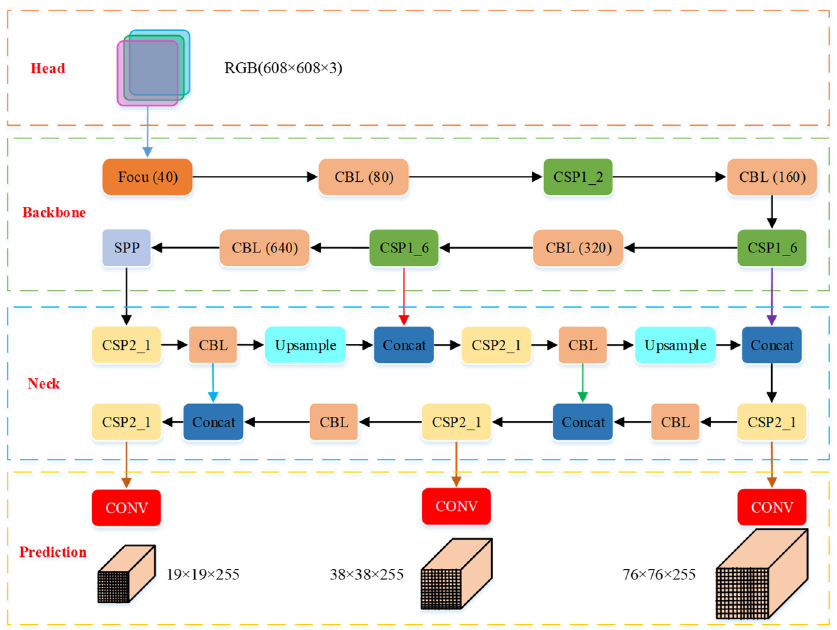
Figure 8. Architecture of improved YOLOv5 network.